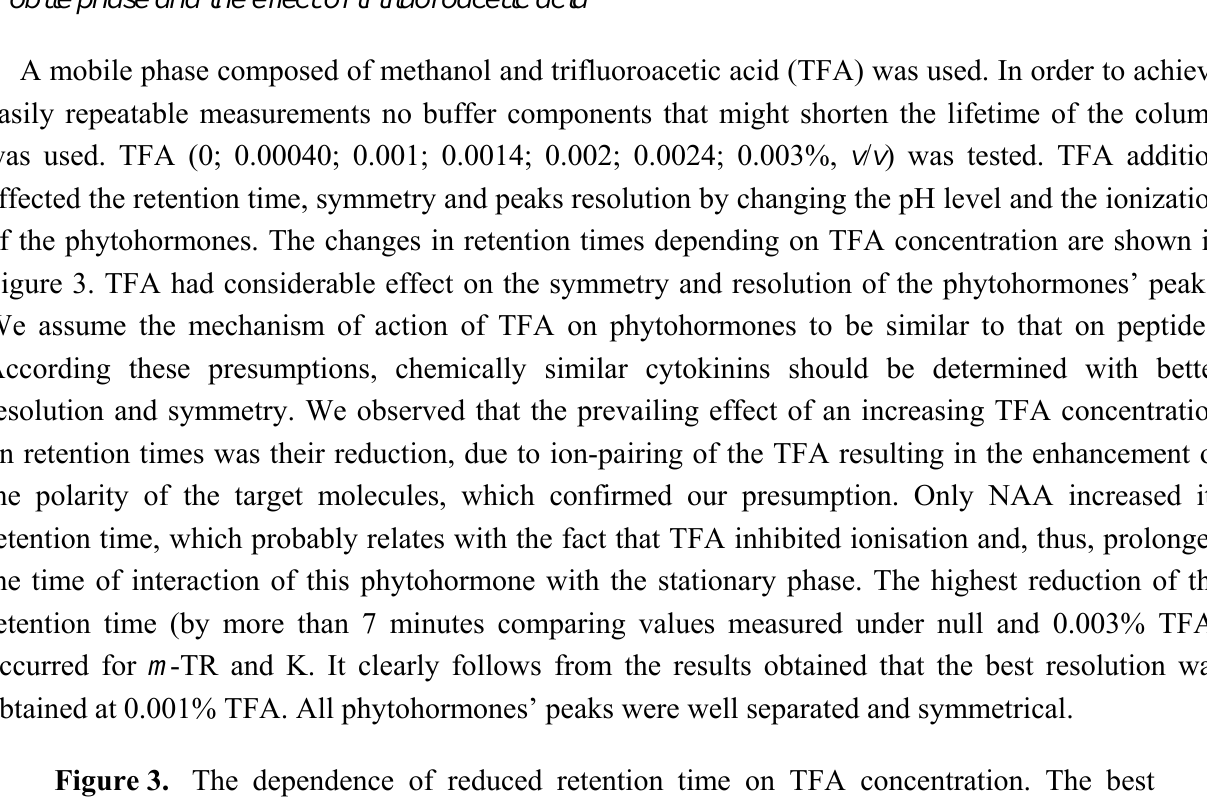
Figure 3. The dependence of reduced retention time on TFA concentration. The best resolution was obtained at TFA concentration 0.001%. The concentrations of individual phytohormones were chosen with respect to similar peaks height and were within the interval from 6 to 20 μ g·mL -1 . The detection was carried out at 210 nm. Linear gradient from 2:98 methanol:TFA (0 min.) up to 85:15 methanol:TFA (40 min.). Mobile phase flow rate of 250 μ L·min -1